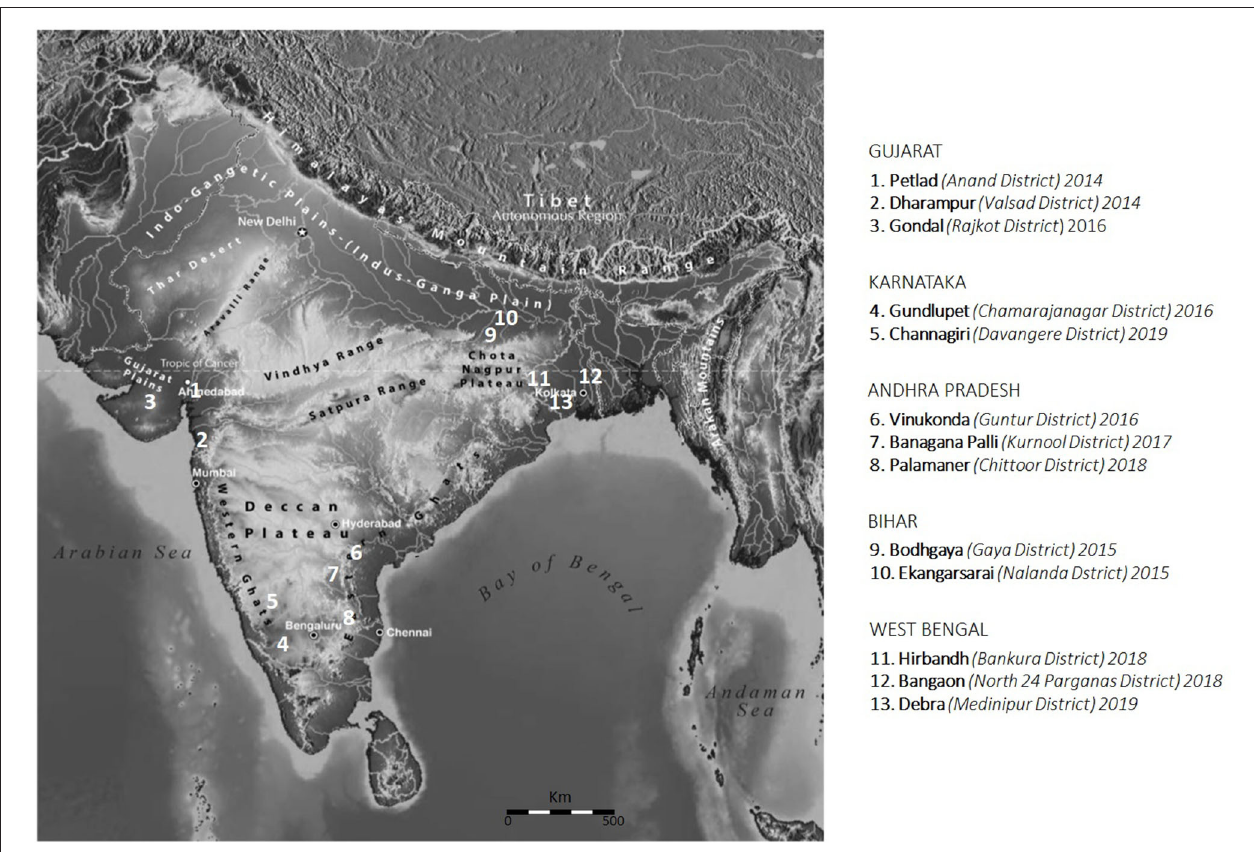
FIGURE 1 | Location and year of the field studies (Source: O.